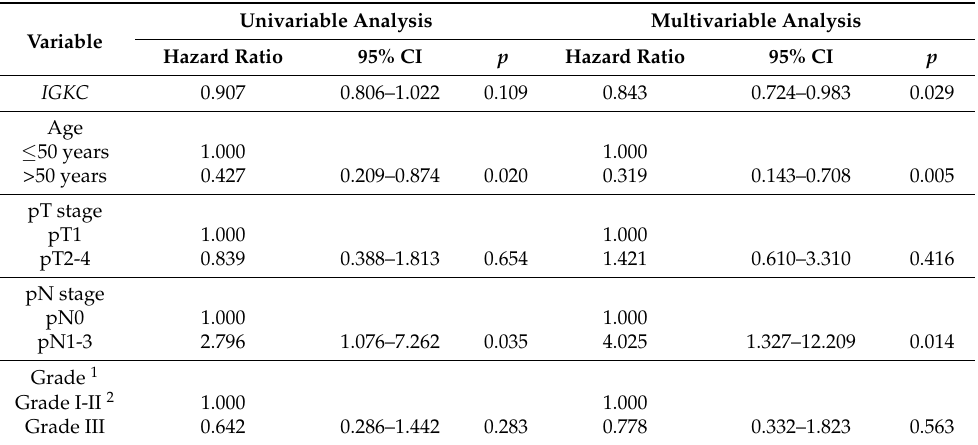
Table 3. Univariable and multivariable Cox analyses for DDFS in patients with TNBC. 132 patients had data for IGKC and were included in the univariable analysis. 129 patients had complete data for all variables and were included in the multivariable analysis. IGKC expression was included as a continuous variable. The corresponding results for IGKC dichotomized using the median or top- quartile expression as a cutoff are shown in Table S3. CI, confidence interval; IGKC, immunoglobulin kappa C; HER2, human epidermal growth factor receptor